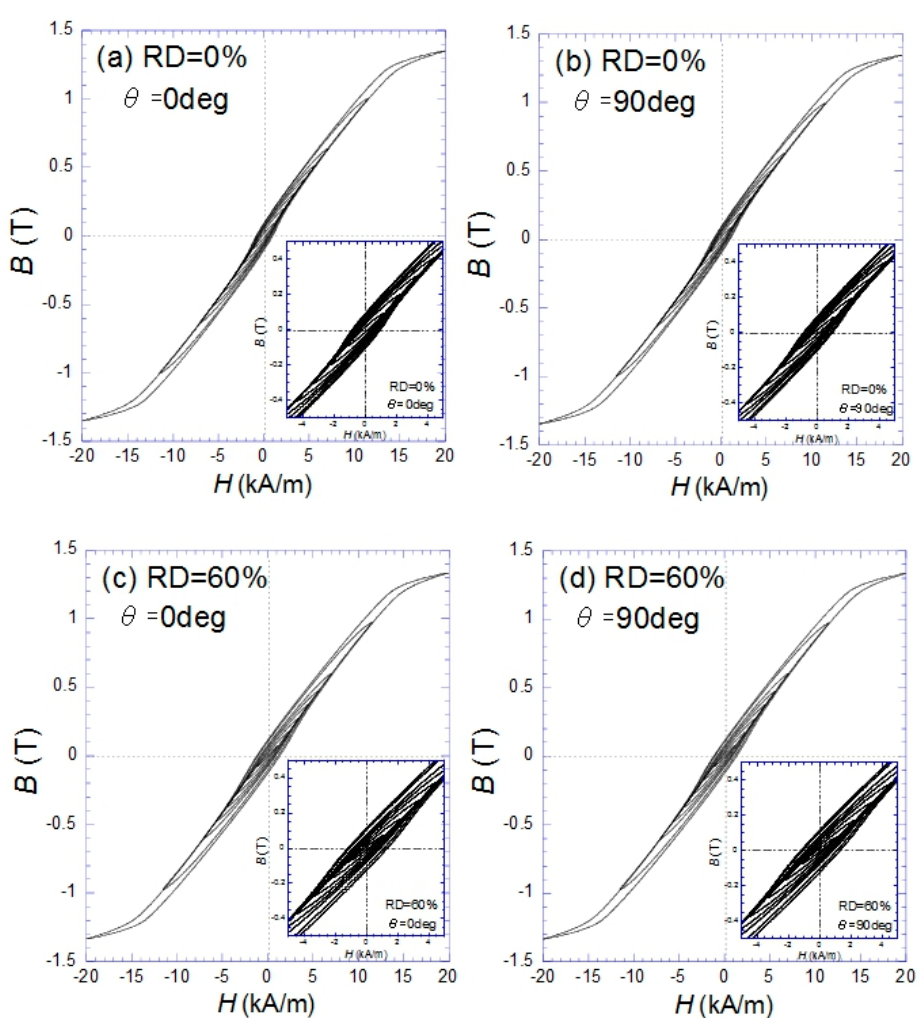
Figure 8. A set of minor B ( H) loops before and after cold rolling. The angle θ represents the rolling direction; ( a ) RD = 0% and θ = 0°, ( b ) RD = 0% and θ = 90°, ( c ) RD = 60% and θ = 0 ° , and ( d ) RD = 60% direction; ( a ) RD = 0% and θ = 0 ◦ , ( b ) RD = 0% and θ = 90 ◦ , ( c ) RD = 60% and θ = 0 ◦ , and ( d ) RD = 60% and θ = 90°. and θ = 90 ◦